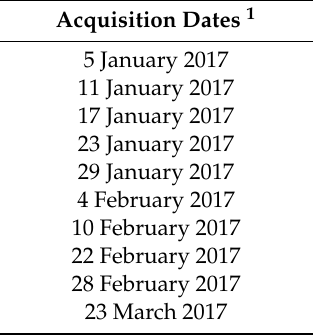
Table 1. 1a and 1b Data